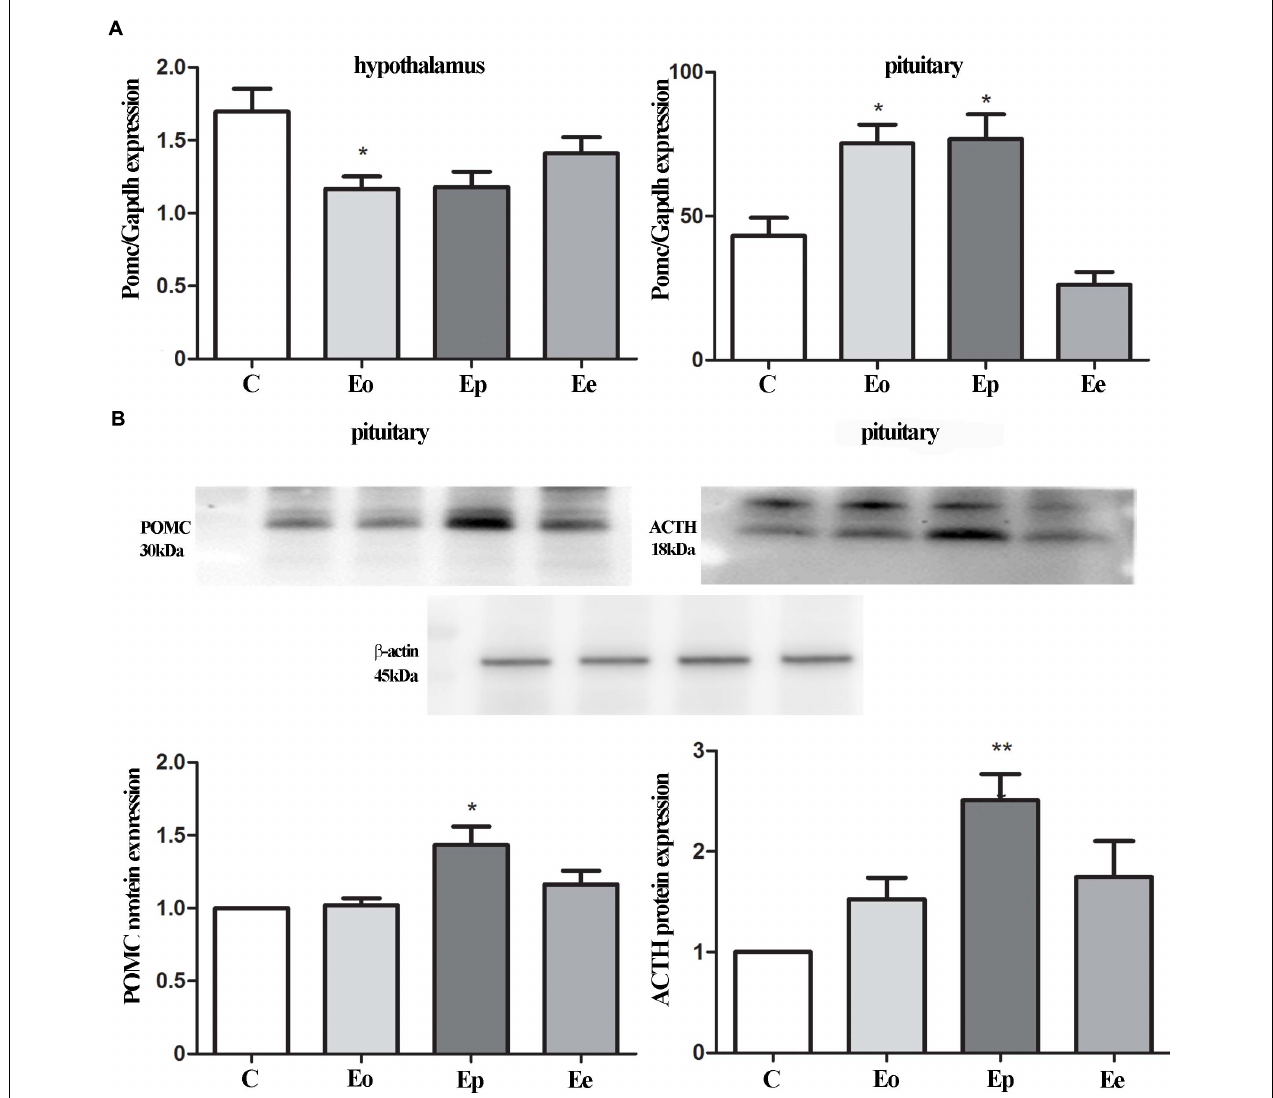
FIGURE 2 | (A) POMC gene expressions were assessed by qRT-PCR in immunized (Eo, Ep, and Ee) and control animals (C–control), with Gapdh as an internal reference standard in the hypothalamus and pituitary. (B) Protein levels of POMC and adrenocorticotropic hormone (ACTH) relative to β -actin in the pituitary were determined using the Western blot method and results are expressed as mean% of control values ± SEM. * p < 0.05; ** p < 0.001 compared with the